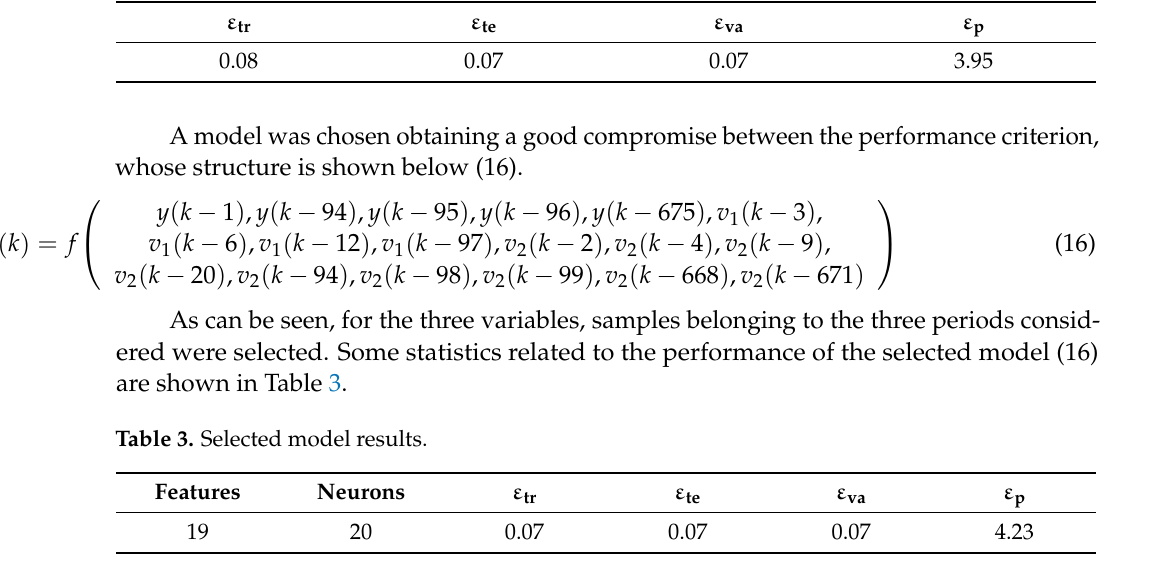
Table 2. Performance for the non-dominated sets.